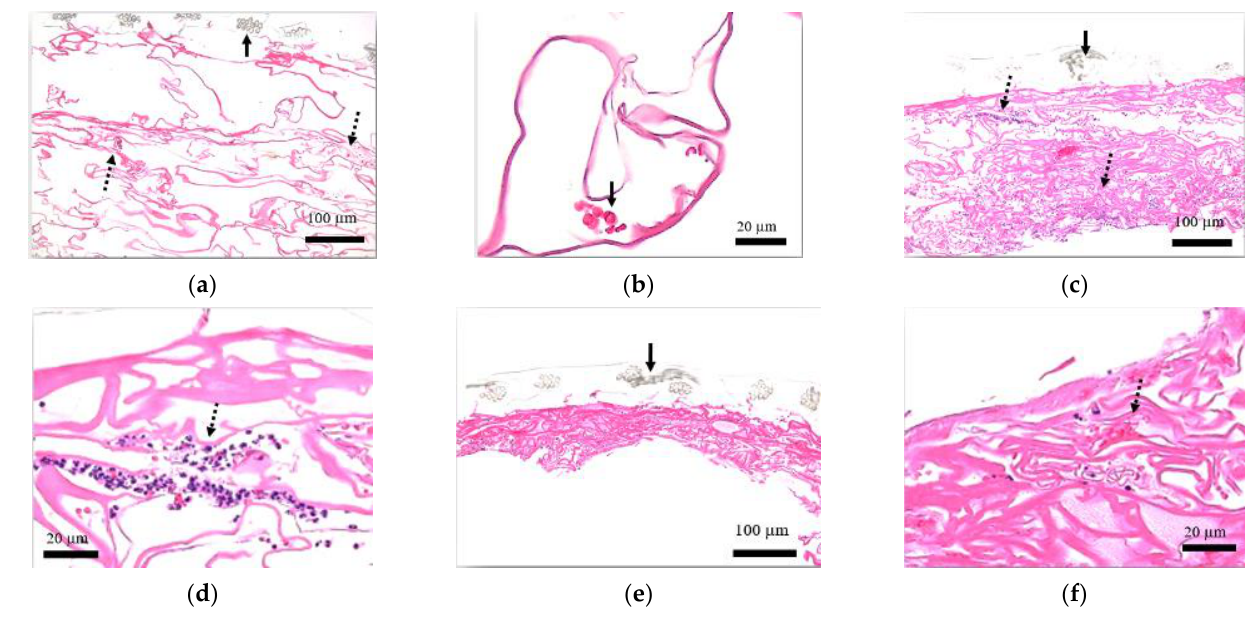
Figure 4. HE evaluation of artificial dermis sample. ( a ) Low power field of view before transplant (40X): Confirmed tissue fragments (dashed arrows) inside the collagen sponge. Solid arrow represents silicone film. ( b ) High power field of view before transplant (200X): Red blood cells (solid arrow) found within the artificial dermis were regarded as influence from the sampling procedure. ( c ) Low power field of view postoperative day 3 (40X): Confirmed a predominance of neutrophils inside the collagen sponge (dashed arrows). Solid arrow represents silicone film. ( d ) High power field of view postoperative day 3 (200X): Confirmed a predominance of neutrophils inside the collagen sponge (dashed arrow). ( e ) Low power field of view postoperative day 7 (40X): Various cells and blood cells, including neutrophils, were detected. In addition, the collagen sponge layer changed over time and became compressed. Solid arrow represents silicone film. ( f ) High power field of view postoperative day 7 (200X): Within the collagen sponge, some blood cells were surrounded by cells with flat nucleus, indicating capillary-like tissues (dashed arrow).